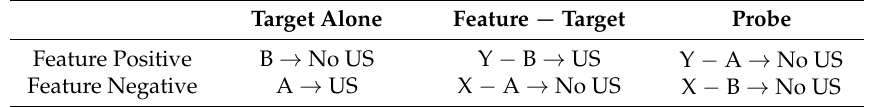
Table 1. Summary of experimental